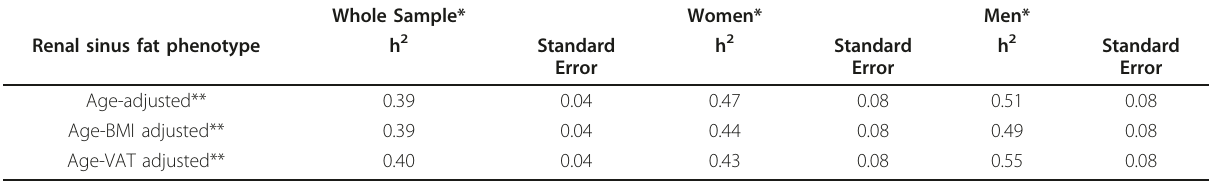
Table 2 Estimated heritability (h 2 ) of renal sinus fat in the Framingham Offspring and Third Generation Cohorts